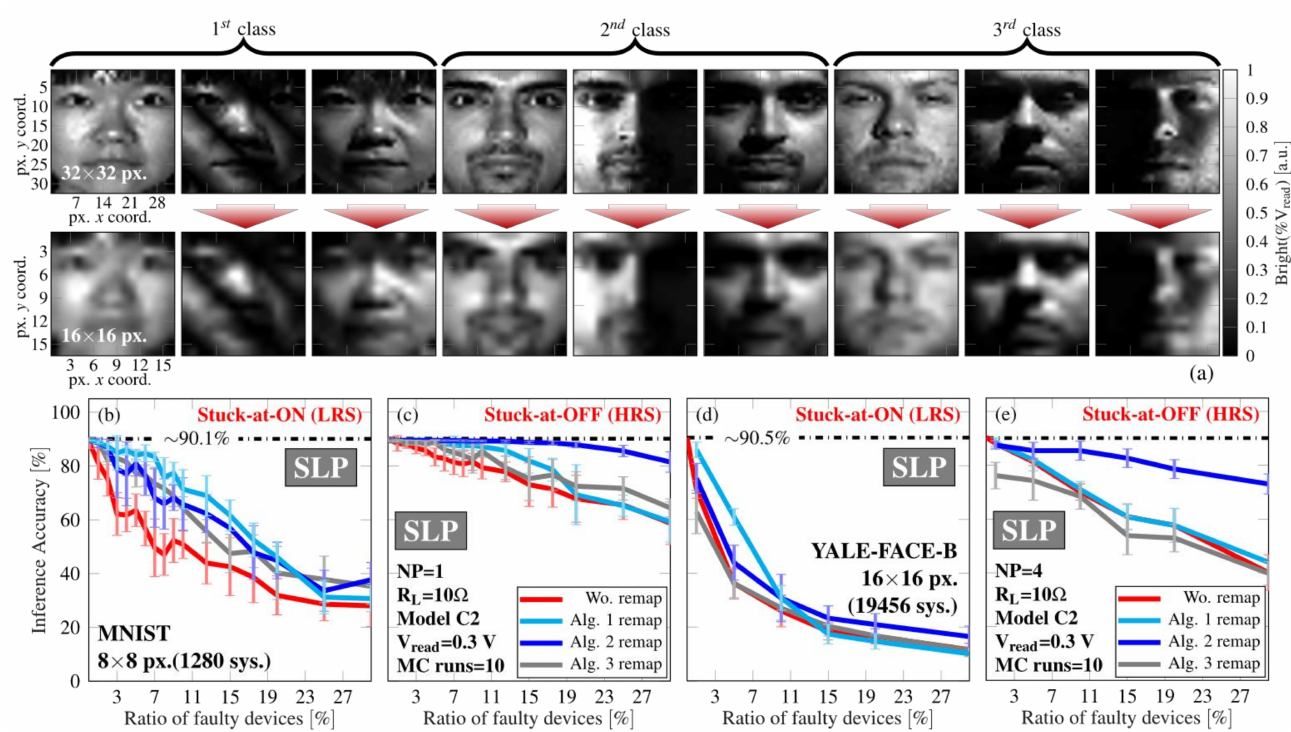
Figure 6. ( a ) Samples of Yale Face Database B showing 3 classes with 32 × 32 px. (top) and 16 × 16 px. (bottom) resolutions. In both cases, the x and y axis in the leftmost image stands for the pixel index. The re-mapping Algorithms 1–3 are tested with the MNIST dataset for the SA1 and SA0 faults in Figures ( b ) and ( c ), respectively. The corresponding trends for Yale Face Database B are shown in Figures ( d ) and ( e ). In both cases, Algorithm 1 shows the best results for SA1 faults and Algorithm 2 is the preferred one to tolerate SA0